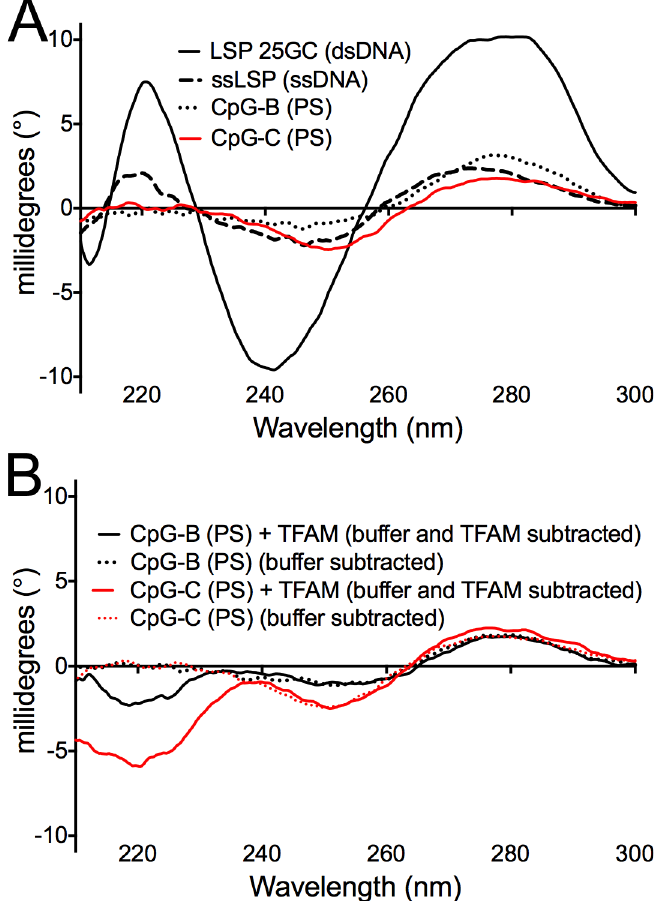
Fig 2. TFAM does not alter the secondary structure of CpG-B or CpG-C (A) Circular dichroism (CD) analysis of CpG-B (PS) and CpG-C ODNs. CD spectra measured in millidegrees are shown for the 25mer dsLSP DNA (solid line), ssLSP ODN (dashed line), CpG-B (PS) ODN (dotted line), and CpG-C (PS) (red line) at a concentration of 20 μ M. (B) CD analysis of CpG-B (PS), and CpG-C (PS) in the presence and absence of TFAM. The DNA concentration was 10 μ M for both samples. In the CpG-B (PS) and CpG-C (PS) spectra, buffer was subtracted, whereas for the CpG-B (PS)+TFAM and CpG-C (PS)+TFAM spectra, the CD contribution both from the buffer and TFAM was subtracted. All CD experiments were conducted at 20°C in 10 mM Na-phosphate buffer and 150 mM